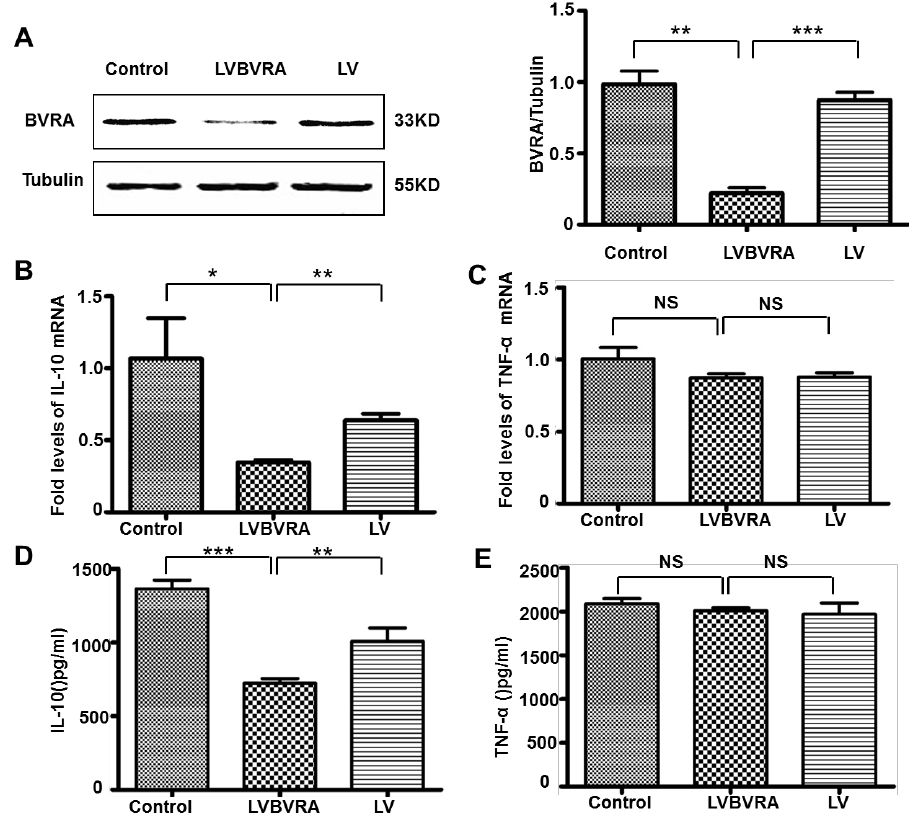
Figure 4. BVRA knockdown macrophages showed decreased IL-10 expression. Macrophages cultured for seven days and transfected with LV-BVRA for 72 h, Western blotting was used to detect the efficiency of knockdown ( A ) ( p < 0.001), IL-10 ( B ) and TNF-α ( C ) mRNA expression were detected by qRT-PCR; IL-10 ( D ) and TNF-α ( E ) protein expression were detected by ELISA. n = 4, *** p < 0.001, ** p <0.01, * p < 0.05. NS: no statistical significance. Control: Macrophages with no virus; LVBVRA: Macrophages transfected with LV-BVRA; LV: Macrophages transfected with LV-negative control.